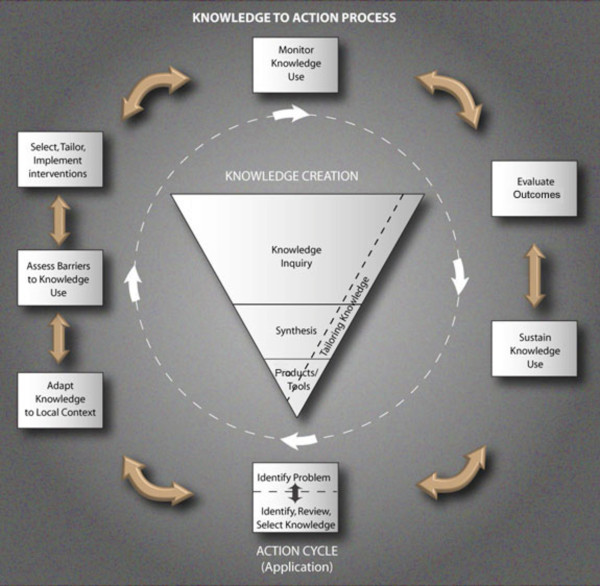
Knowledge-to-Action (KTA) process. Source: Graham et al. (2006) [22].